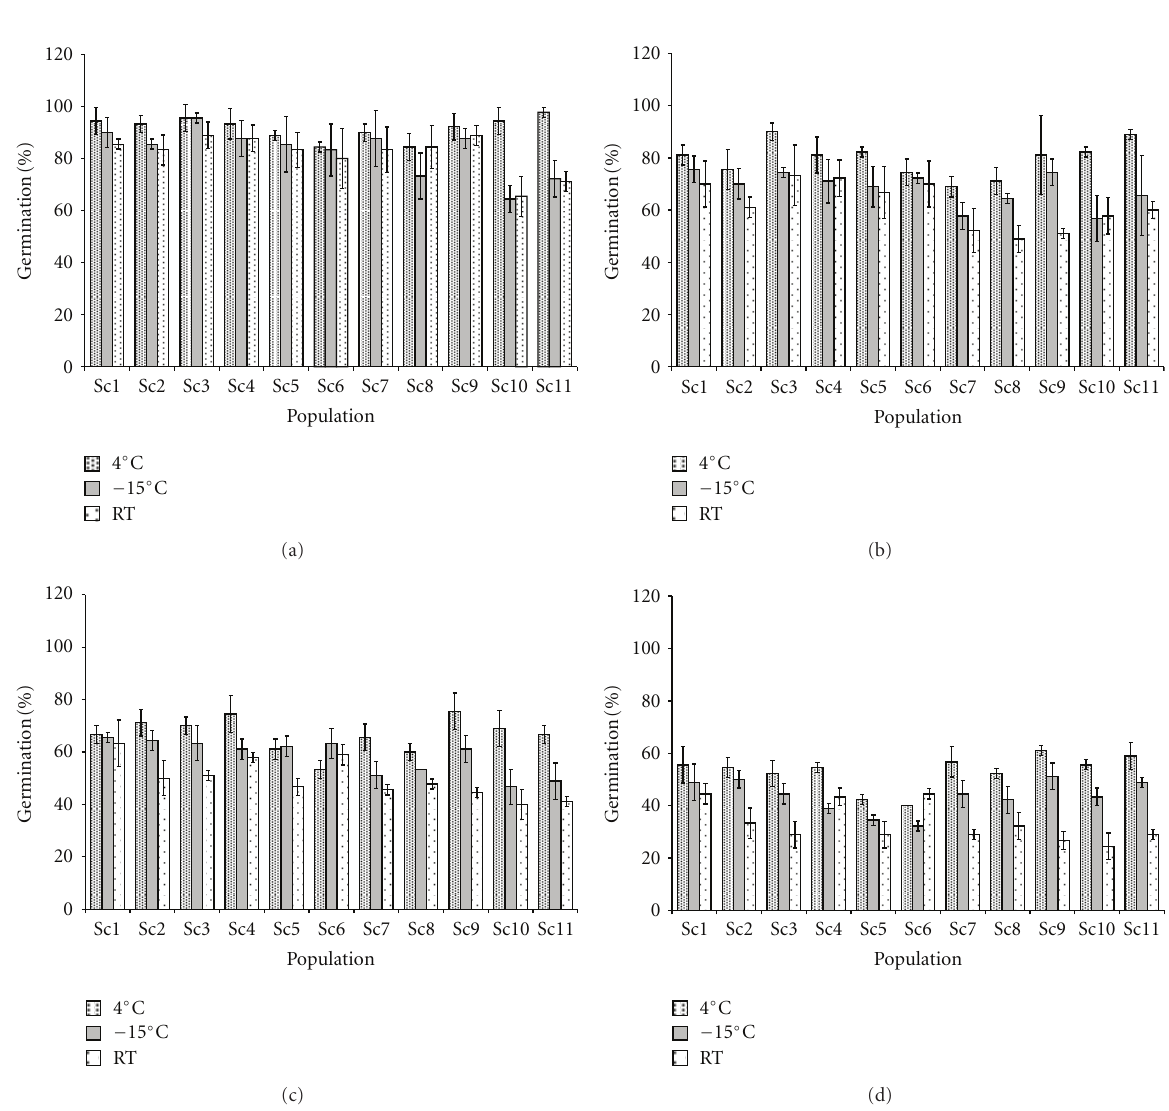
Figure 3: E ff ect of storage conditions and storage period on mean seed germination in populations of Swertia chirayita (a) 6 month; (b) 12 month; (c) 18 month; (d) 24 month ( vertical bars indicate the standard deviation; 30 seeds × 3 replicates per population used; RT: room temperature